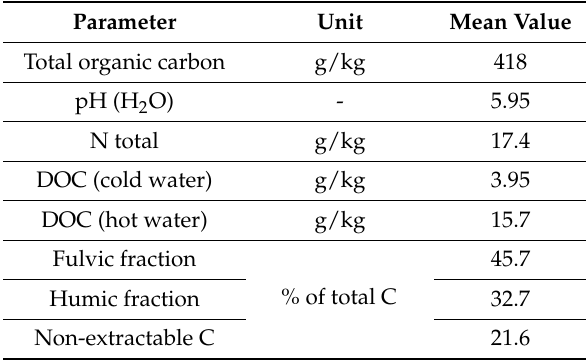
Table 2. Basic properties and fractional composition of beech forest litter 1 .